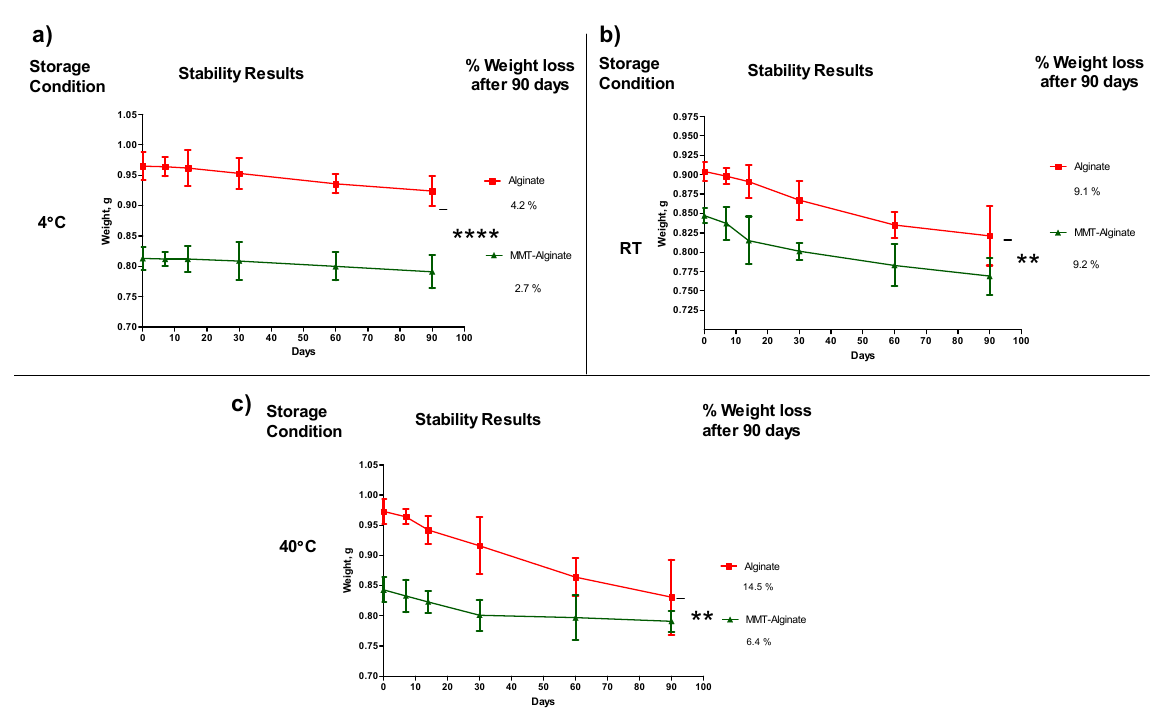
Figure 3. Three months of stability study of the alginate and MMT-enhanced alginate capsules. The study was performed in three different temperatures: ( a ) 4 ◦ C, ( b ) room temperature (RT), and ( c ) elevated temperature 40 ◦ C. The stability/significant difference was judged based on the capsule weight at 90 days ( n = 4, ± D). Signs **** and ** represents a significant difference.